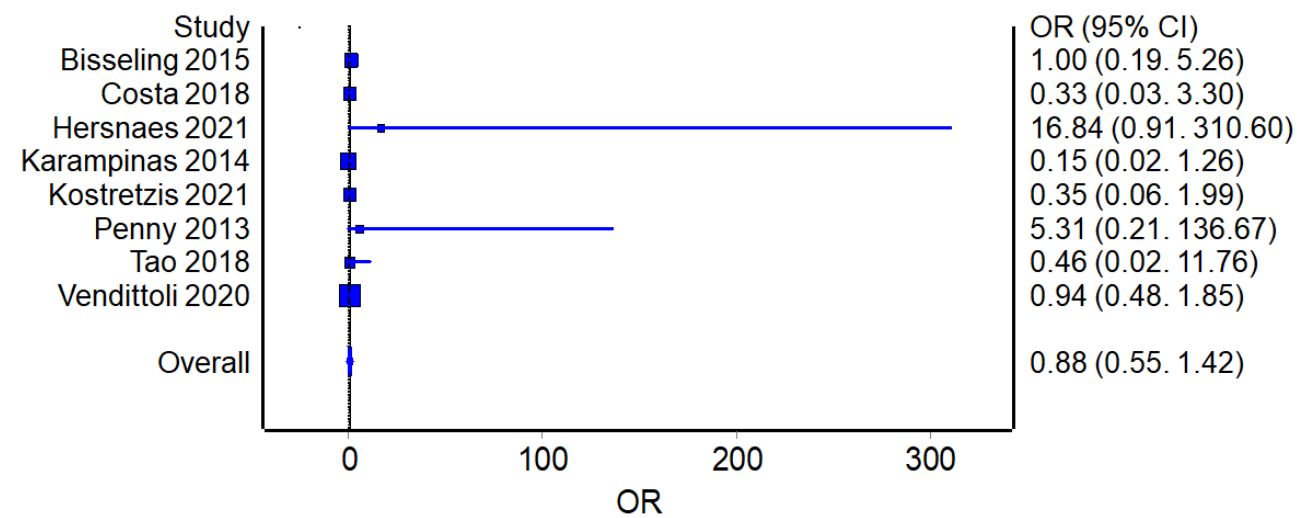
Figure 5. Revision Rates: Forest plot of the individual studies and pooled mean difference for revision rates, including a 95% confidence interval. The size of the squares shows the weight of the study [15 – 22,24 – 31].